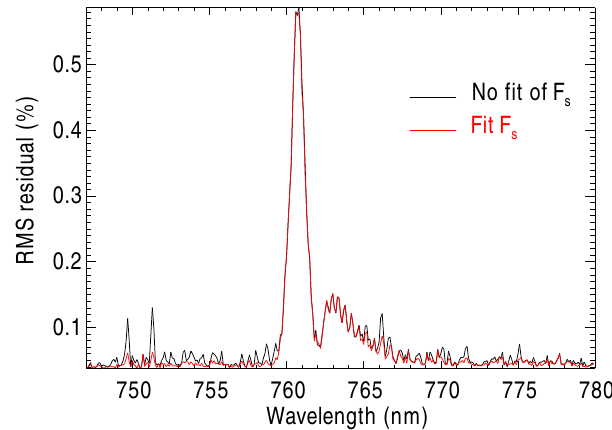
Fig. 13. RMS of simulated radiance residuals (in percent of radiance) from the testing data set with FWHM = 0.3nm and SNR = 2000 when fluorescence radiance ( F s ) is fitted/retrieved and when it is not fitted/retrieved.